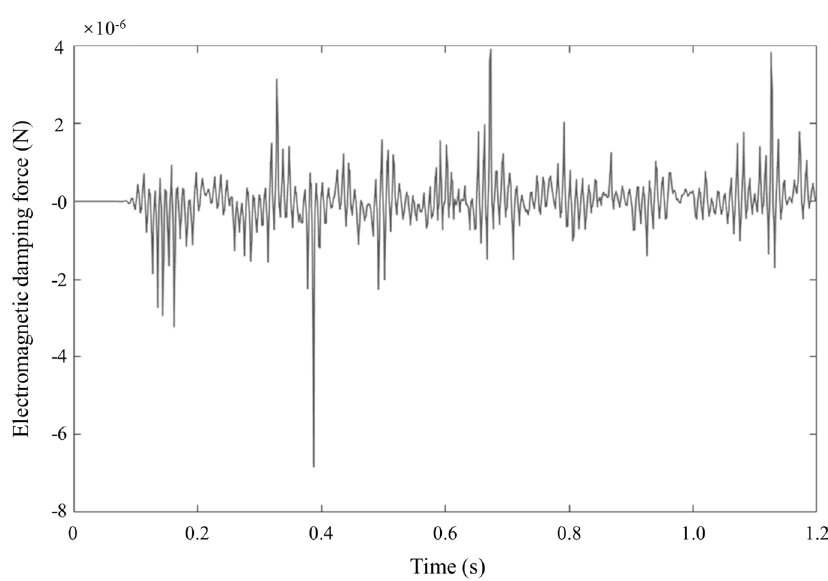
Figure 17. Coil electromagnetic damping force during the energy harvesting.